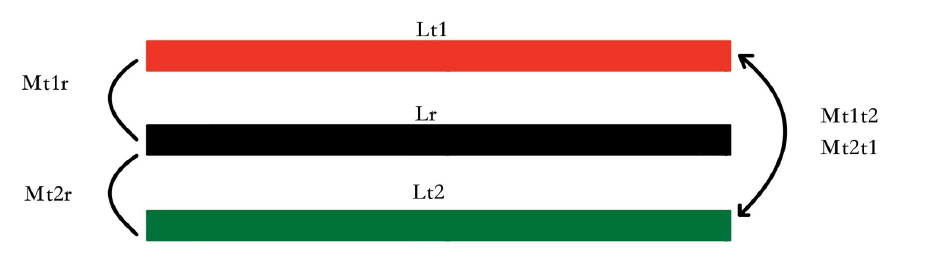
Figure 6. The schematic diagram of cross-coupling between coils.